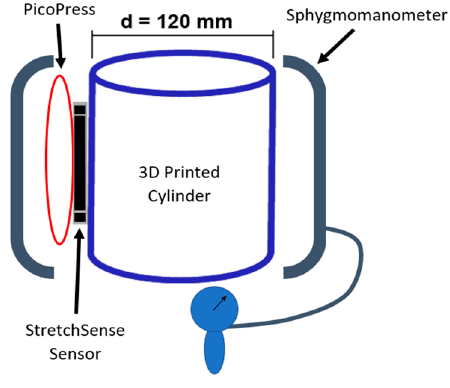
Figure 7. PicoPress and StretchSense pneumatic comparison